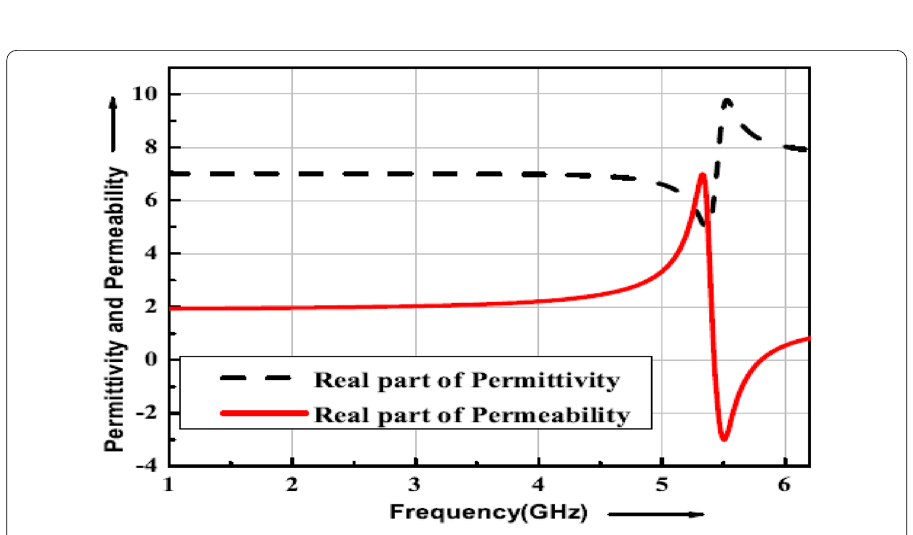
Fig. 7 Real permittivity and permeability of split ring